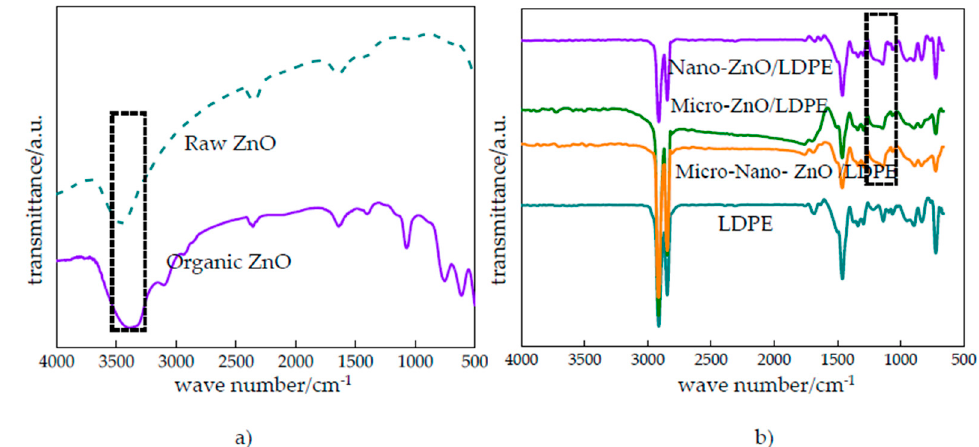
Figure 6. FTIR patterns of ( a ) ZnO particles; ( b ) LDPE, Nano-ZnO/LDPE, Micro-ZnO/LDPE and Micro-Nano-ZnO/LDPE specimens.